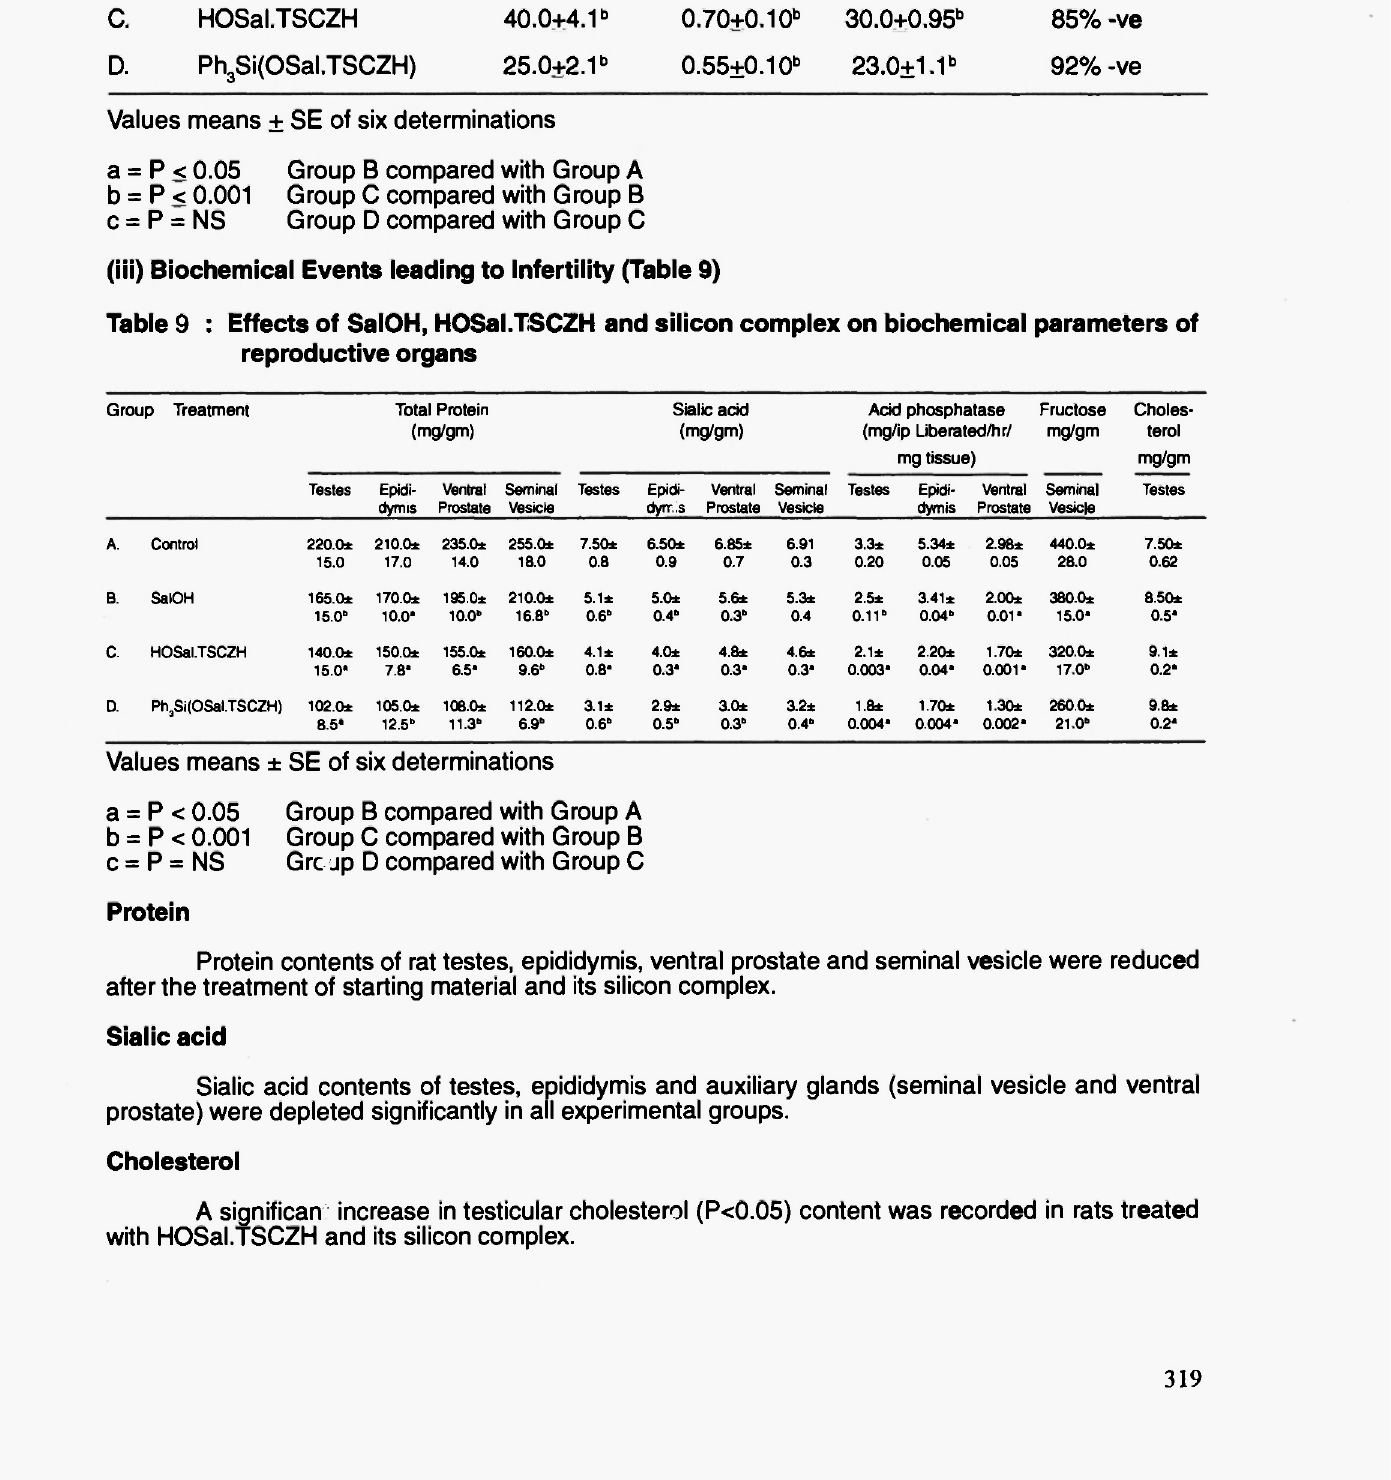
Table 9 : Effects of SalOH, HOSal.TSCZH and silicon complex on biochemical parameters of reproductive